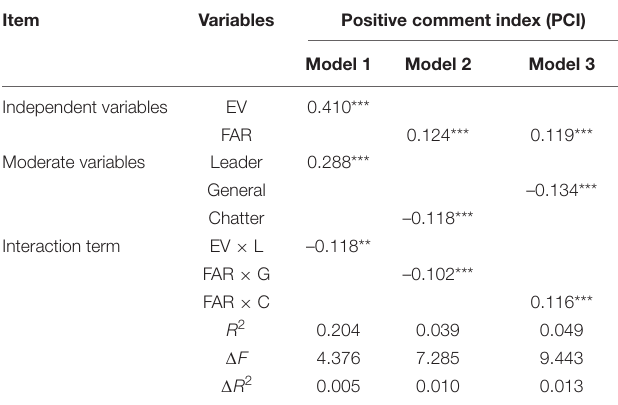
TABLE 10 | Test results of human characteristics moderate effect ( N =